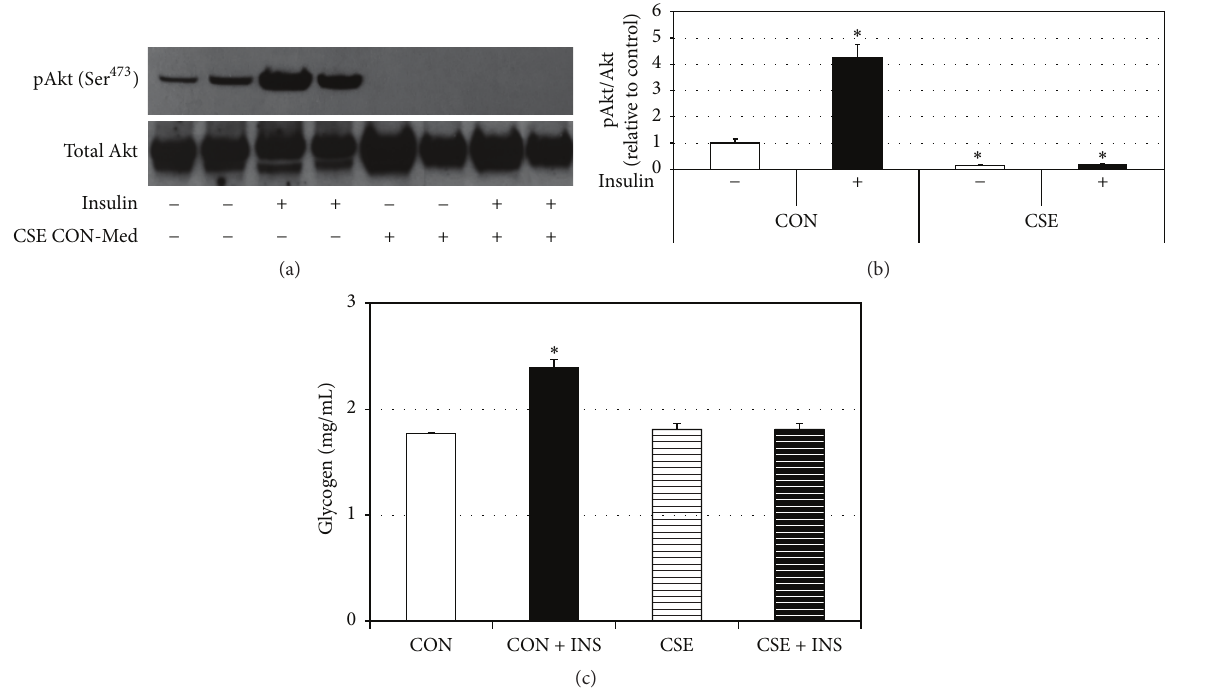
Figure 2: CSE-treated gingival cell conditioned medium alters myotube insulin signaling. Following treatment with conditioned medium, myotubes were stimulated with insulin (100nM) for 10min prior to lysing. Western blot for pAkt and total Akt ((a); 𝑛 = 3 ) was performed and quantified ((b); 𝑛 = 3 ). Glycogens levels were also measured in similarly treated cells ((c); 𝑛 = 6 ). ∗ 𝑃 < 0.05 : CSE versus CON.